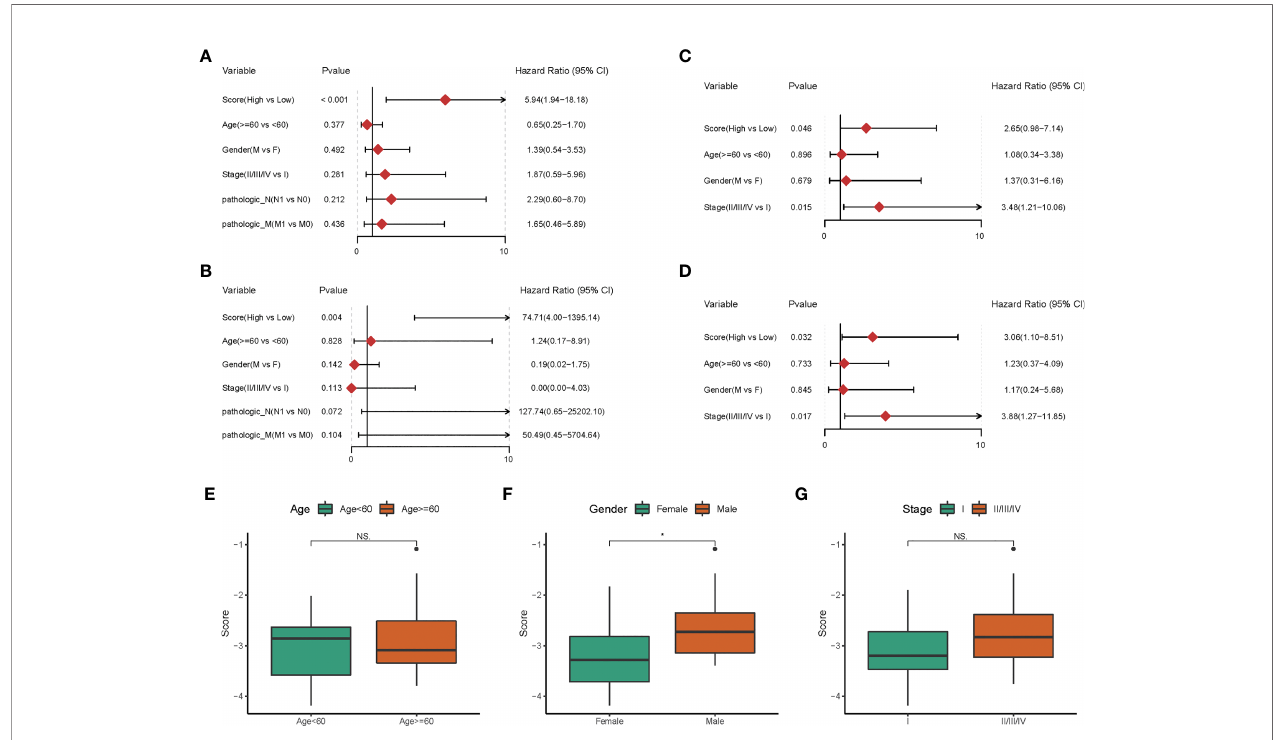
FIGURE 3 | The Hypoxia-related risk score is an independent prognostic factor. (A-D) The forest plot of the univariate and multivariate Cox regression analysis shows that the risk score was an independent risk factor for overall survival in training dataset and validation dataset. (E-G) The box line chart of the differences in the distribution of risk scores by grouping patients based on their age, gender and stage.